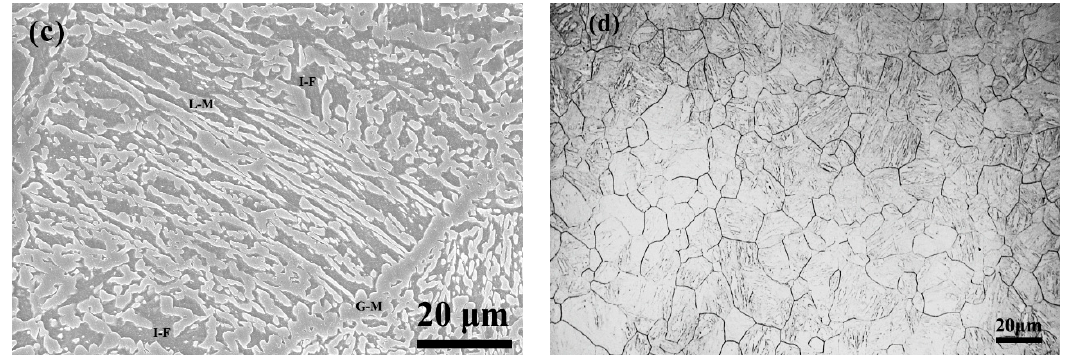
Figure 2. SEM images of hot rolled plate steel ( a ) and specimen 2# ( c ) by nital etching; optical microscope images of specimen 1# ( b ) and specimen 3# ( d ) by picric etching; M/A: martensite and austenite constituent; I-F: intercritical ferrite; L-M: martensite distributed at laths; G-M: martensite distributed at prior austenite grain boundary; γ a and γ b : austenite grain.